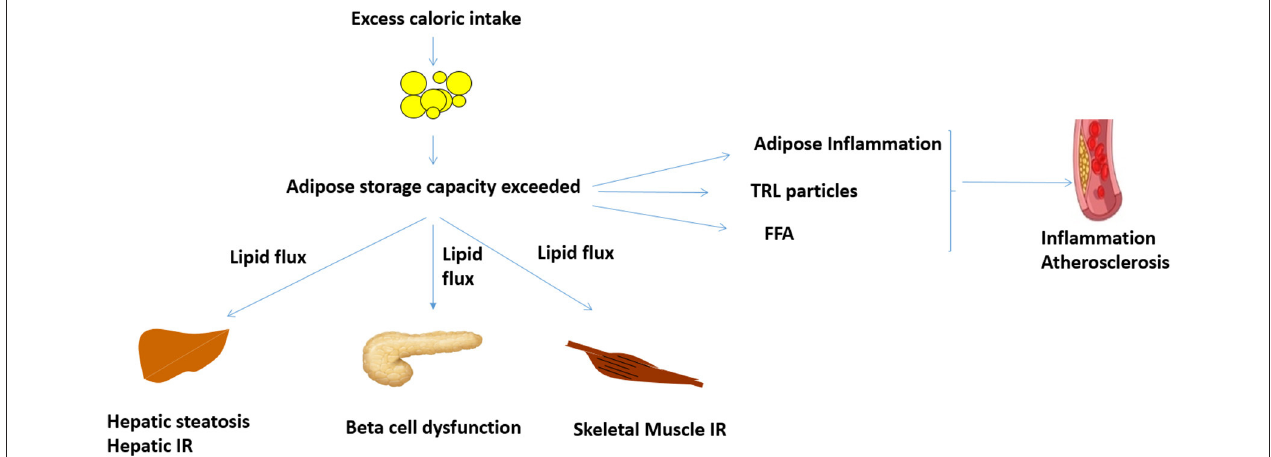
FIGURE 1 | Proposed mechanisms linking obesity, inflammation and cardiovascular disease. When adipose storage capacity is exceeded, increased lipid flux, and ectopic lipid in liver, skeletal muscle, and pancreas reduce insulin sensitivity and beta cell function. Compromised adipose storage is also associated with adipose and systemic inflammation, which can potentially potentiate atheroma development. Increased TRL and FFA, which are features of insulin resistance, may also increase inflammation and atheroma development. FFA, free fatty acids; IR, insulin resistance; TRL, triglyceride rich lipoproteins